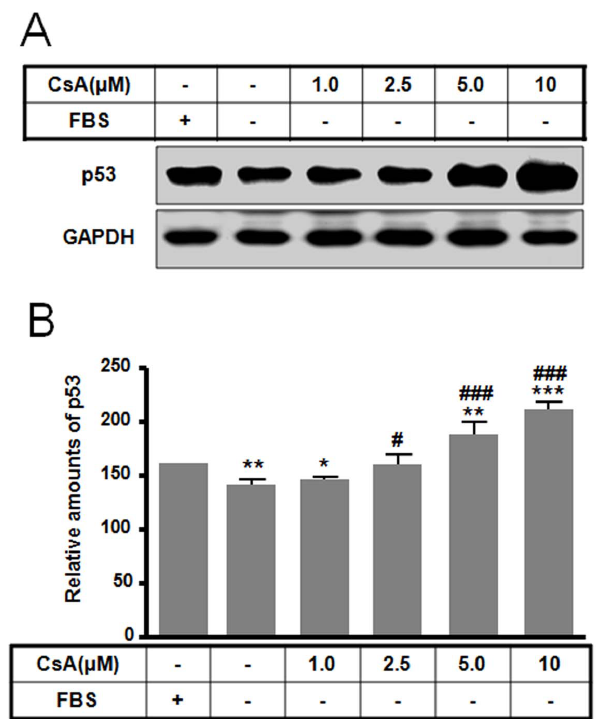
Figure 2. Effect of CsA-mediated apoptotic cell death on p53 expression levels. GH3 cells were incubated in DMEM with or without 10% fetal bovine serum in the presence or absence of CsA (0 to 10 m M) for 10 h. p53 expression (A) was determined by Western blotting and the relative amount (B) was calculated as described in the Materials and Methods. * p , 0.05, ** p , 0.01 vs. serum treatment. # p , 0.05, ### p , 0.001 vs. no serum treatment.